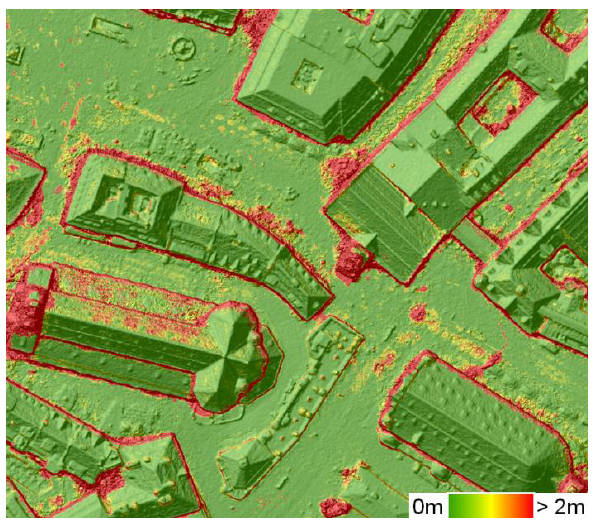
Figure 1. Shaded DSM for test area München with RMS differences for all solutions overlaid